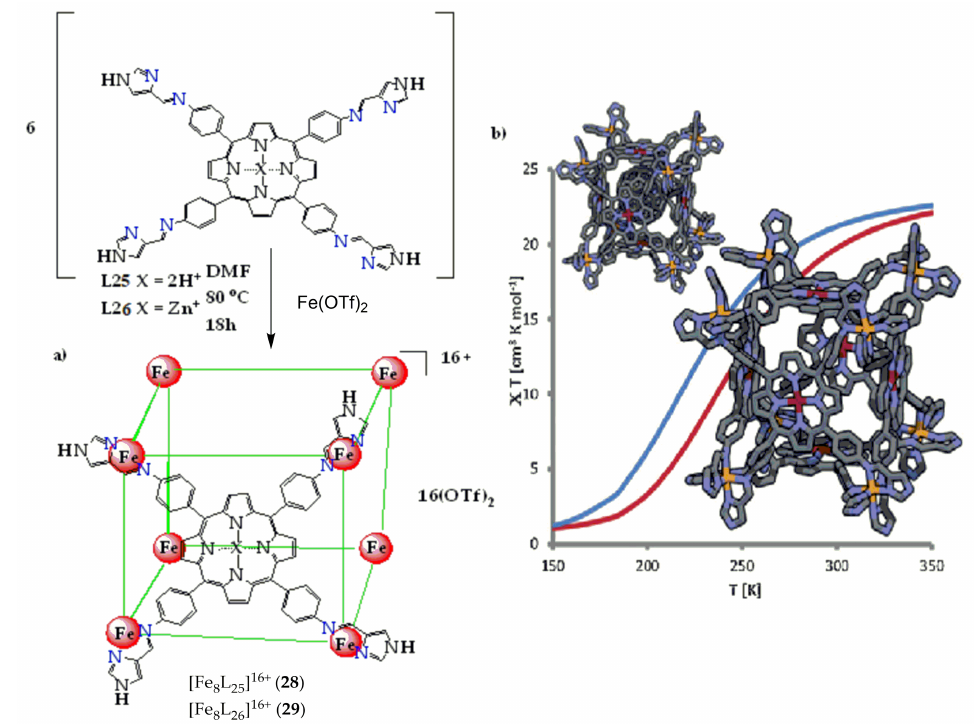
Figure 18. ( a ) Hetero-bimetallic cubic architecture of [Fe 8 L 25 ] 16+ ( 28 ) and [Fe 8 L 26 ] 16+ ( 29 ) ( b ) χ M T vs. T plots of C 70 guest encapsulated ( top ) and empty cavity ( bottom ) complex 29. Reproduced with permission from [105]; Published by Wiley,